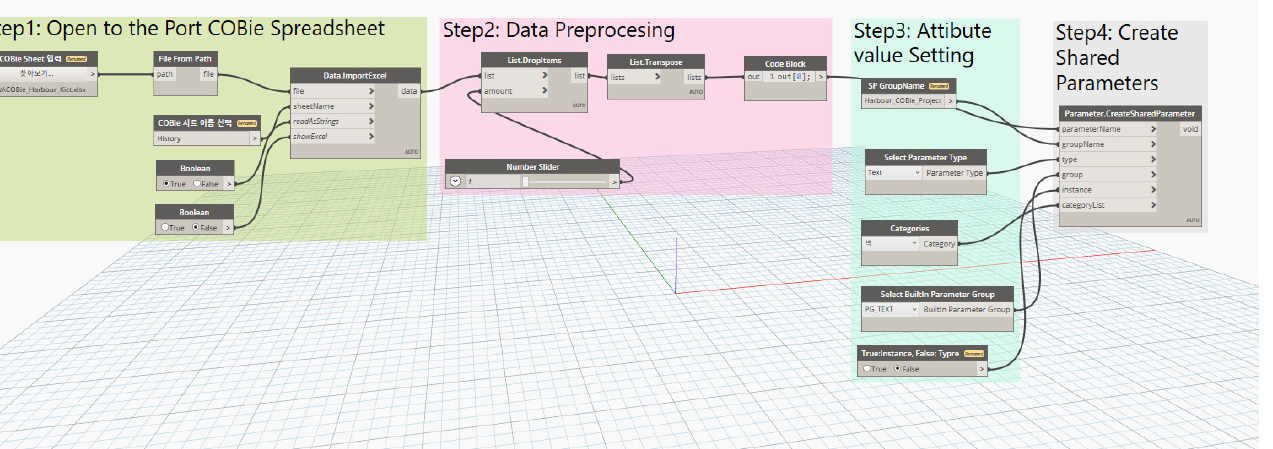
Figure 15. Converting COBie data into shared parameters. Once the shared parameters were created, project parameters were created there from before the port COBie properties were parametrized. The project parameters were created because shared parameters cannot accommodate all of the COBie property values. In addition, the project parameters allow each COBie property to be defined using the type or instance parameters in Revit. “Type parameter” refers to the type of property, as